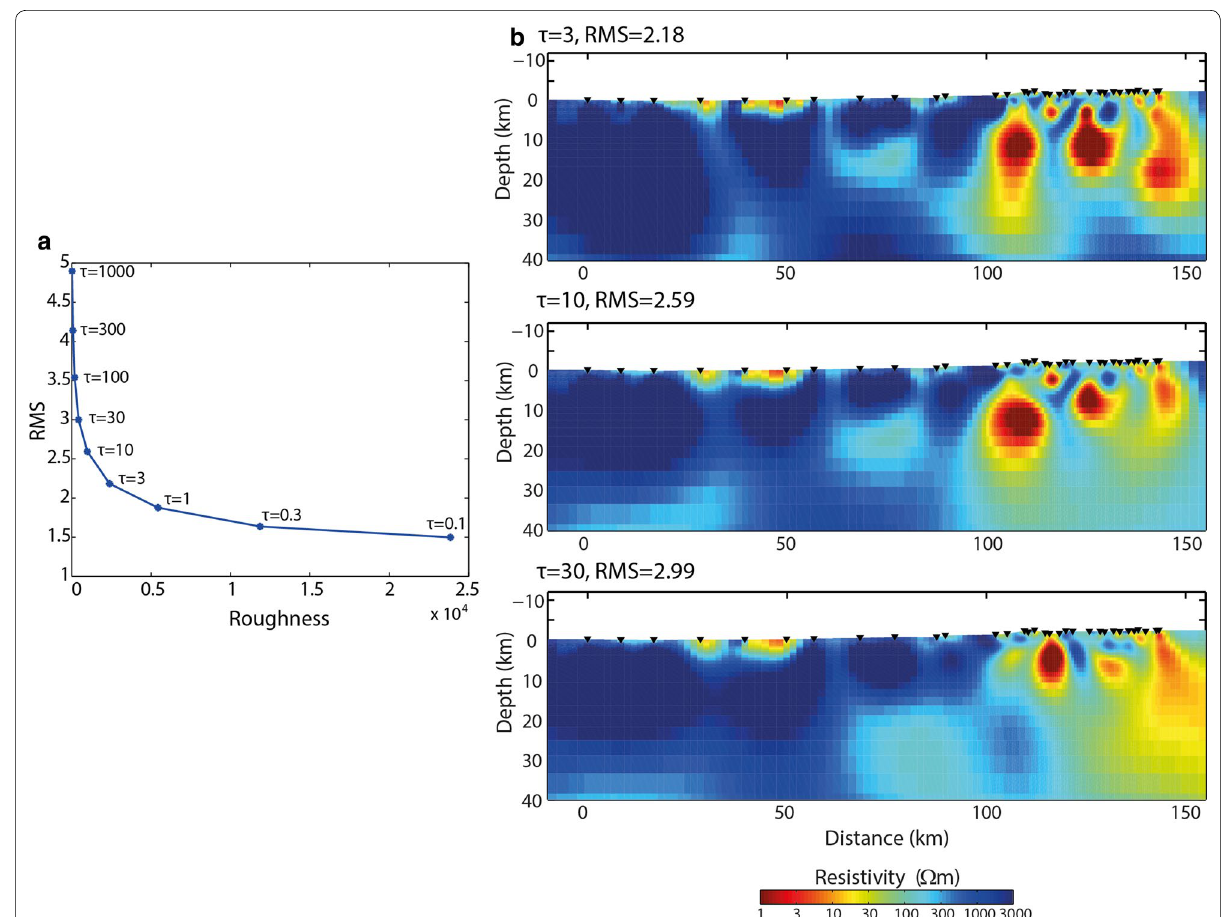
Fig. 4 Determination of τ value. a L‑curve for different τ values ranging from 0.1 to 1000. b 2D inversion models obtained with τ τ =